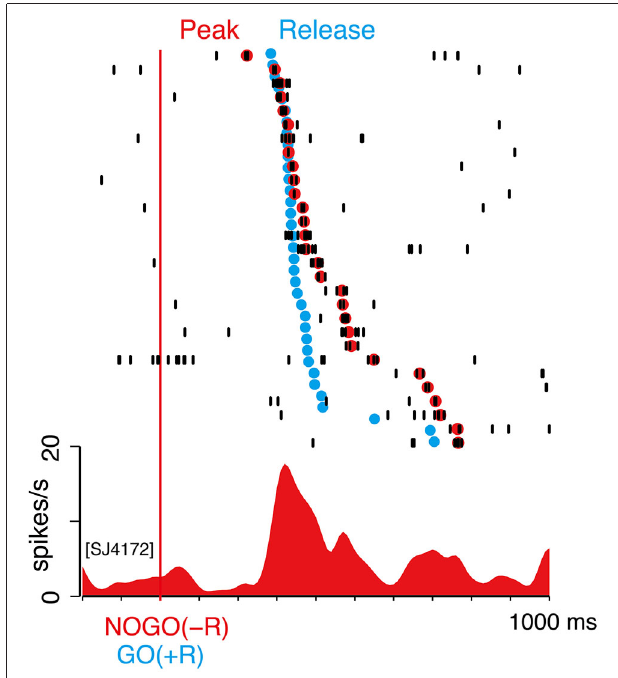
FIGURE 7 | NOGO( − R) activations did not precede GO( + R) action . Example of NOGO( − R) response of the same neuron in Figure 6A , aligned according to NOGO( − R) onset. Raster displays of spikes are shown in order of shorter peak latency from top to bottom. Red dots indicate time of peak activity. The trials in which peak activity was not detected are not shown. Onset time of GO( + R) action in the same block is superimposed on the raster display by blue